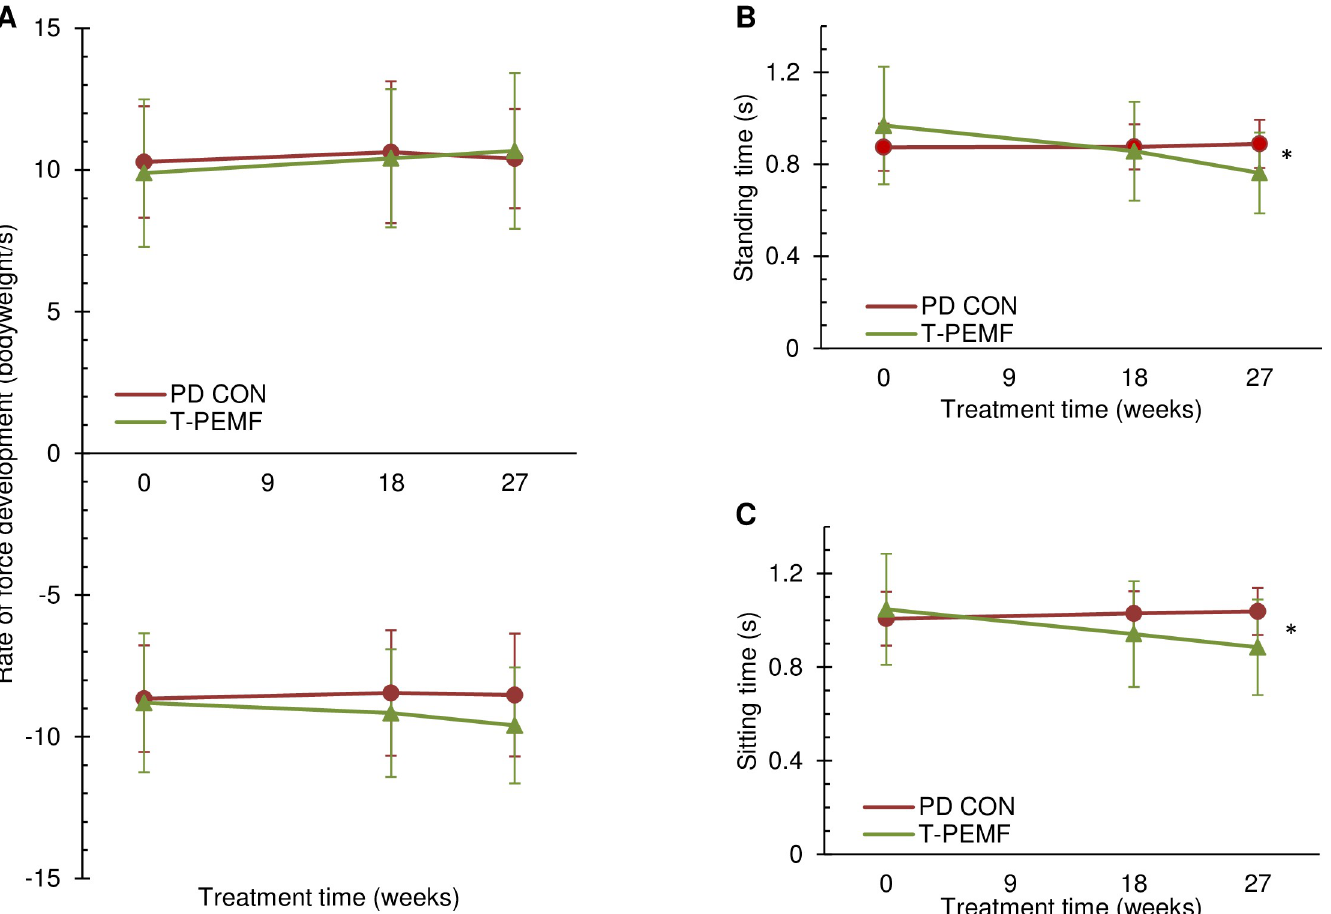
Fig 2. Subdivision of the sit-to-stand movement. Rate of force development during rising from a chair (A, upper) and lowering to a chair (A, lower), standing time (B) and sitting time (C) for the group receiving T-PEMF treatment (T-PEMF; green, solid line with triangles) and the PD control group (PD CON; red, solid line with circles). � Significant between-group difference in performance over time ( P <